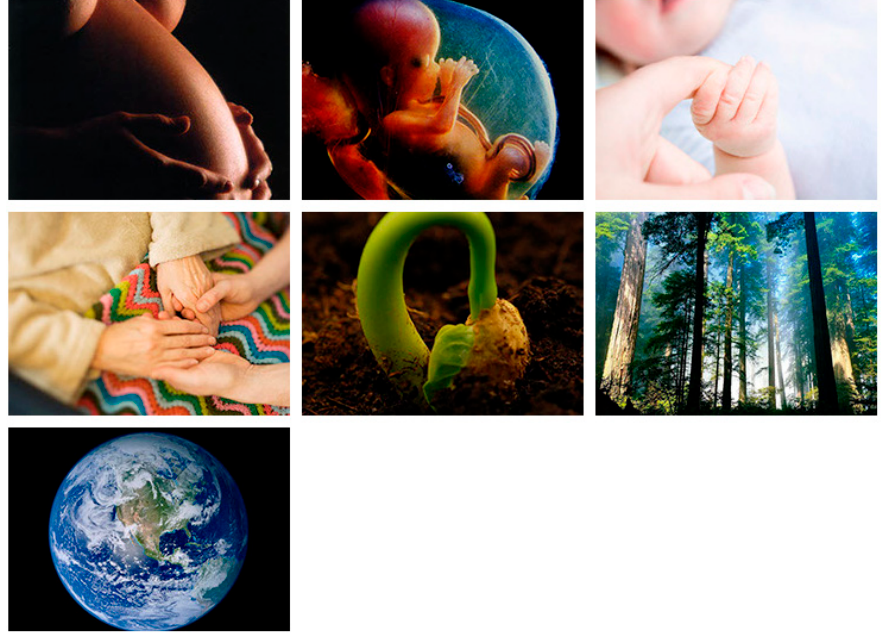
Figure 2. Imaginary of Spíritree, directly linking feminine qualities of giving birth and nourishment to the health of our planet.